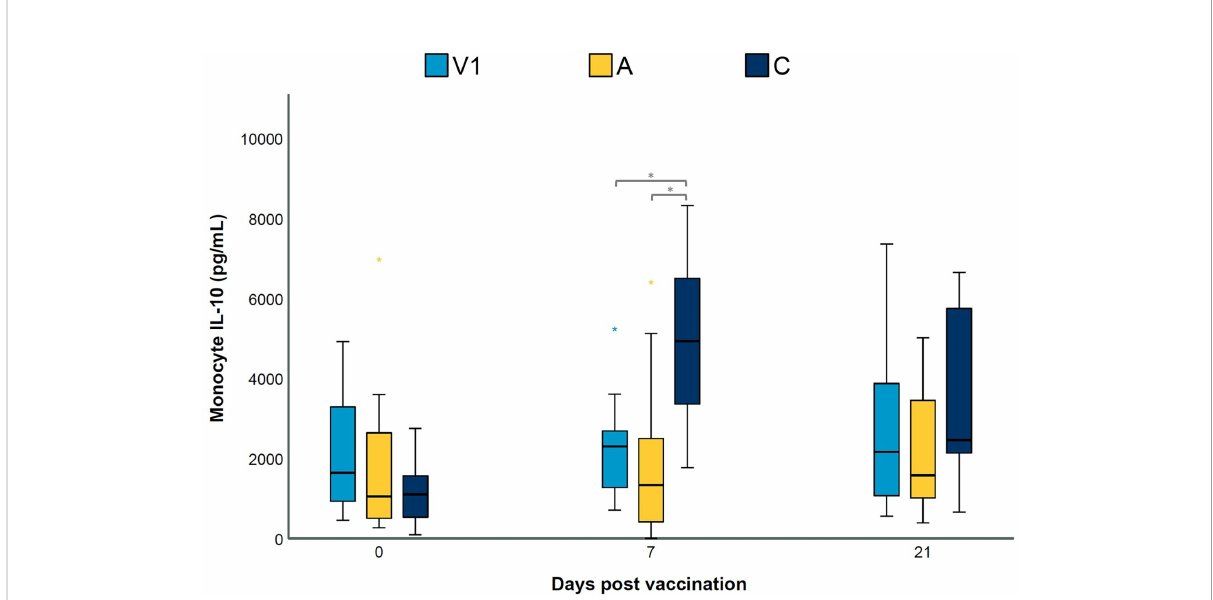
FIGURE 6 LPS-induced IL-10 secretion by blood monocytes. Piglets were vaccinated on D0 with V1, A, V2 or physiological saline solution (C), and animals were challenge infected on D21 and euthanized on D49. The concentration (pg/mL) of secreted IL-10 in cell-culture medium by LPS-stimulated blood monocytes was determined using a multiplex immunoassay. For each time point, signi fi cance was calculated using a Kruskal – Wallis H- test with Dunn-Bonferroni post hoc test. Statistical results were considered signi fi cant when p ≤ 0.05